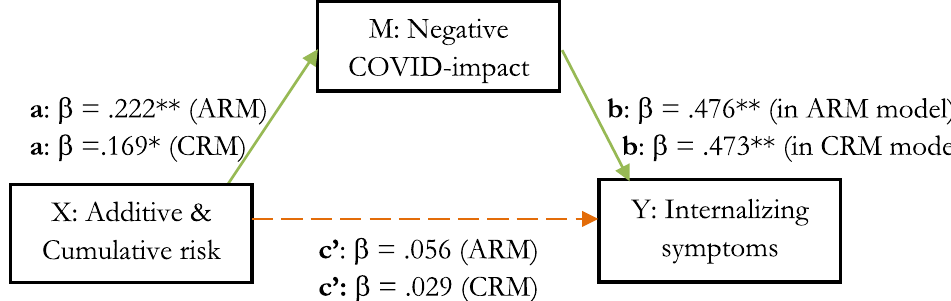
Figure 2. Mediation effects. ARM/CRM → Negative COVID-impact → Internalizing symptoms . Note. Green arrow = significant, orange dashed arrow = non-significant in separate model and still non-significant when negative COVID-impact is added to the model; * p < 0.01 & ** p < 0.001.